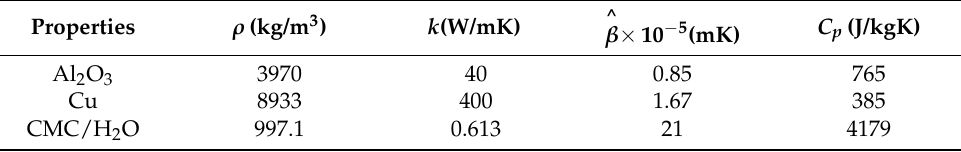
Table 2. The thermophysical properties of selected nanoparticles and base fluid (sodium car- boxymethyl cellulose(CMC)/water). The values presented in this table have been adapted from previous works by Oztop and Abu-Nada [37] as well as Abbas et al.